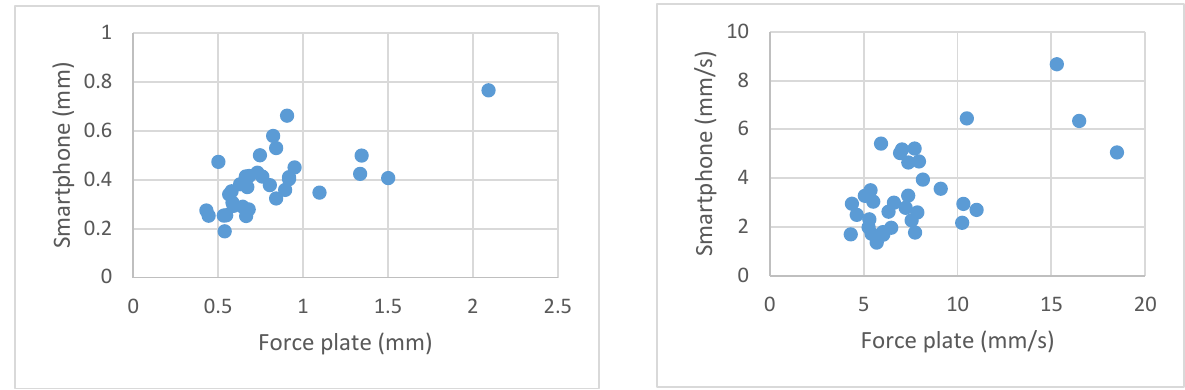
Figure 3. Average path length (on the left) and average velocity (on the right) as evaluated from the force plate and smart phone application results (33 subjects).